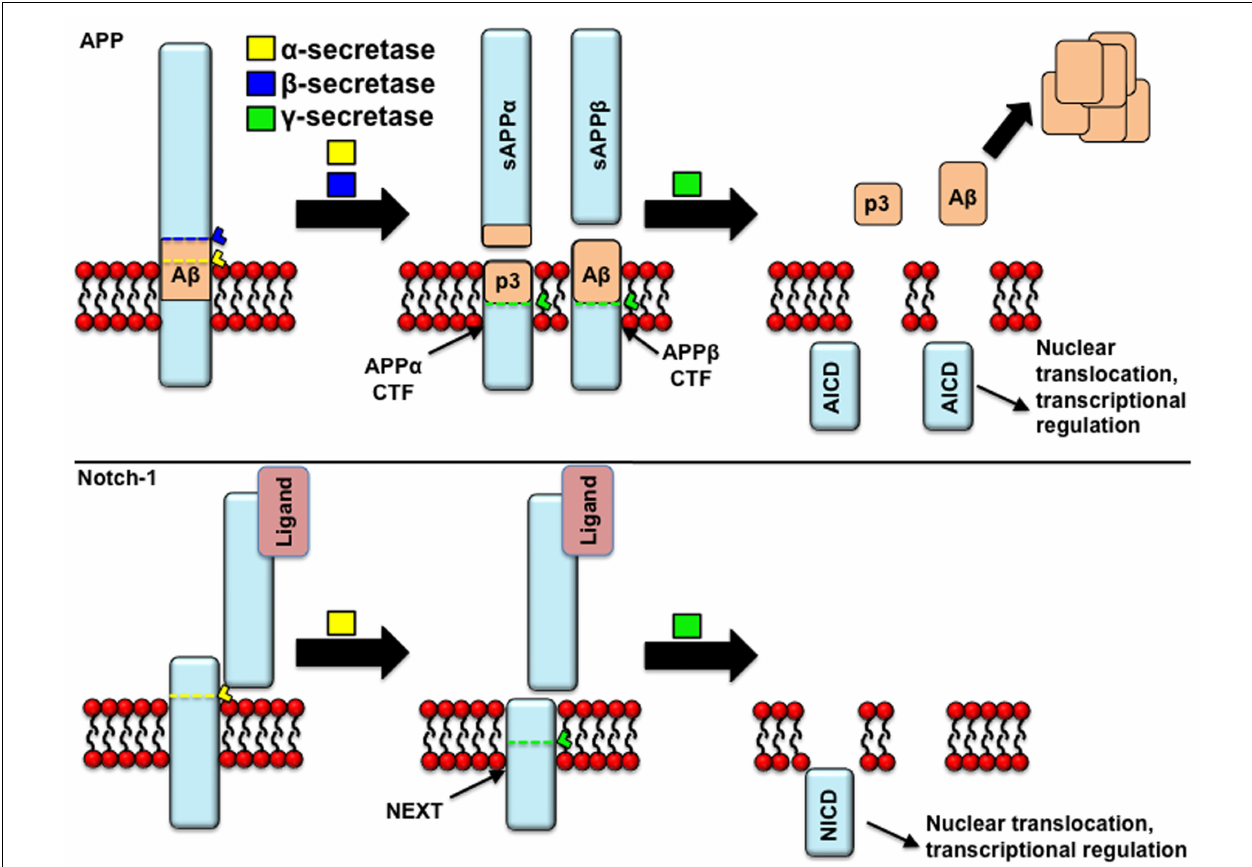
by a furin-like protease activity in the juxtamembrane extracellular domain, giving rise to two fragments (120 and 180kDa) that remain associated as a heterodimer. It is thought that Notch reaches the cell membrane in this assembly, where it can undergo activation by ligand binding, following which it gets cleaved by α -secretase to yield the “Notch extracellular truncated” derivative (NEXT). Similarly to the APP-CTFs, only this truncated derivative is then cleaved by γ -secretase. Similarly to NICD, AICD fragments are thought to translocate to the nucleus and activate gene